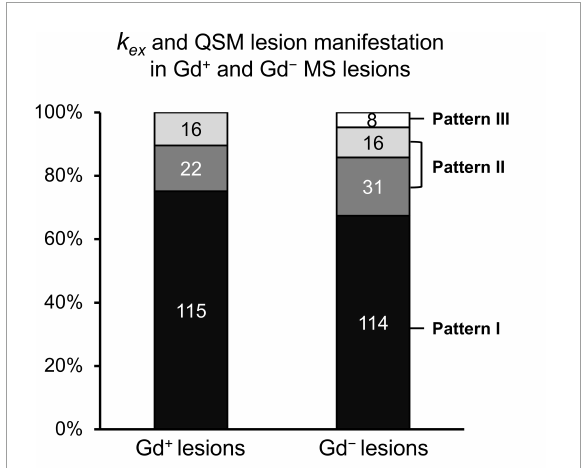
FIGURE3 Extended classification of Gd – lesions. Gd – lesions were categorized into Pattern I (which are k ex + and QSM + ); Pattern II (which are either k ex + and QSM – , or k ex – and QSM + ); and Pattern III (which are k ex – and QSM – ) according to lesion manifestation on the k ex map and QSM images. All Gd + lesions were considered as one category despite the inconsistent lesion manifestation on the k ex map and QSM images.